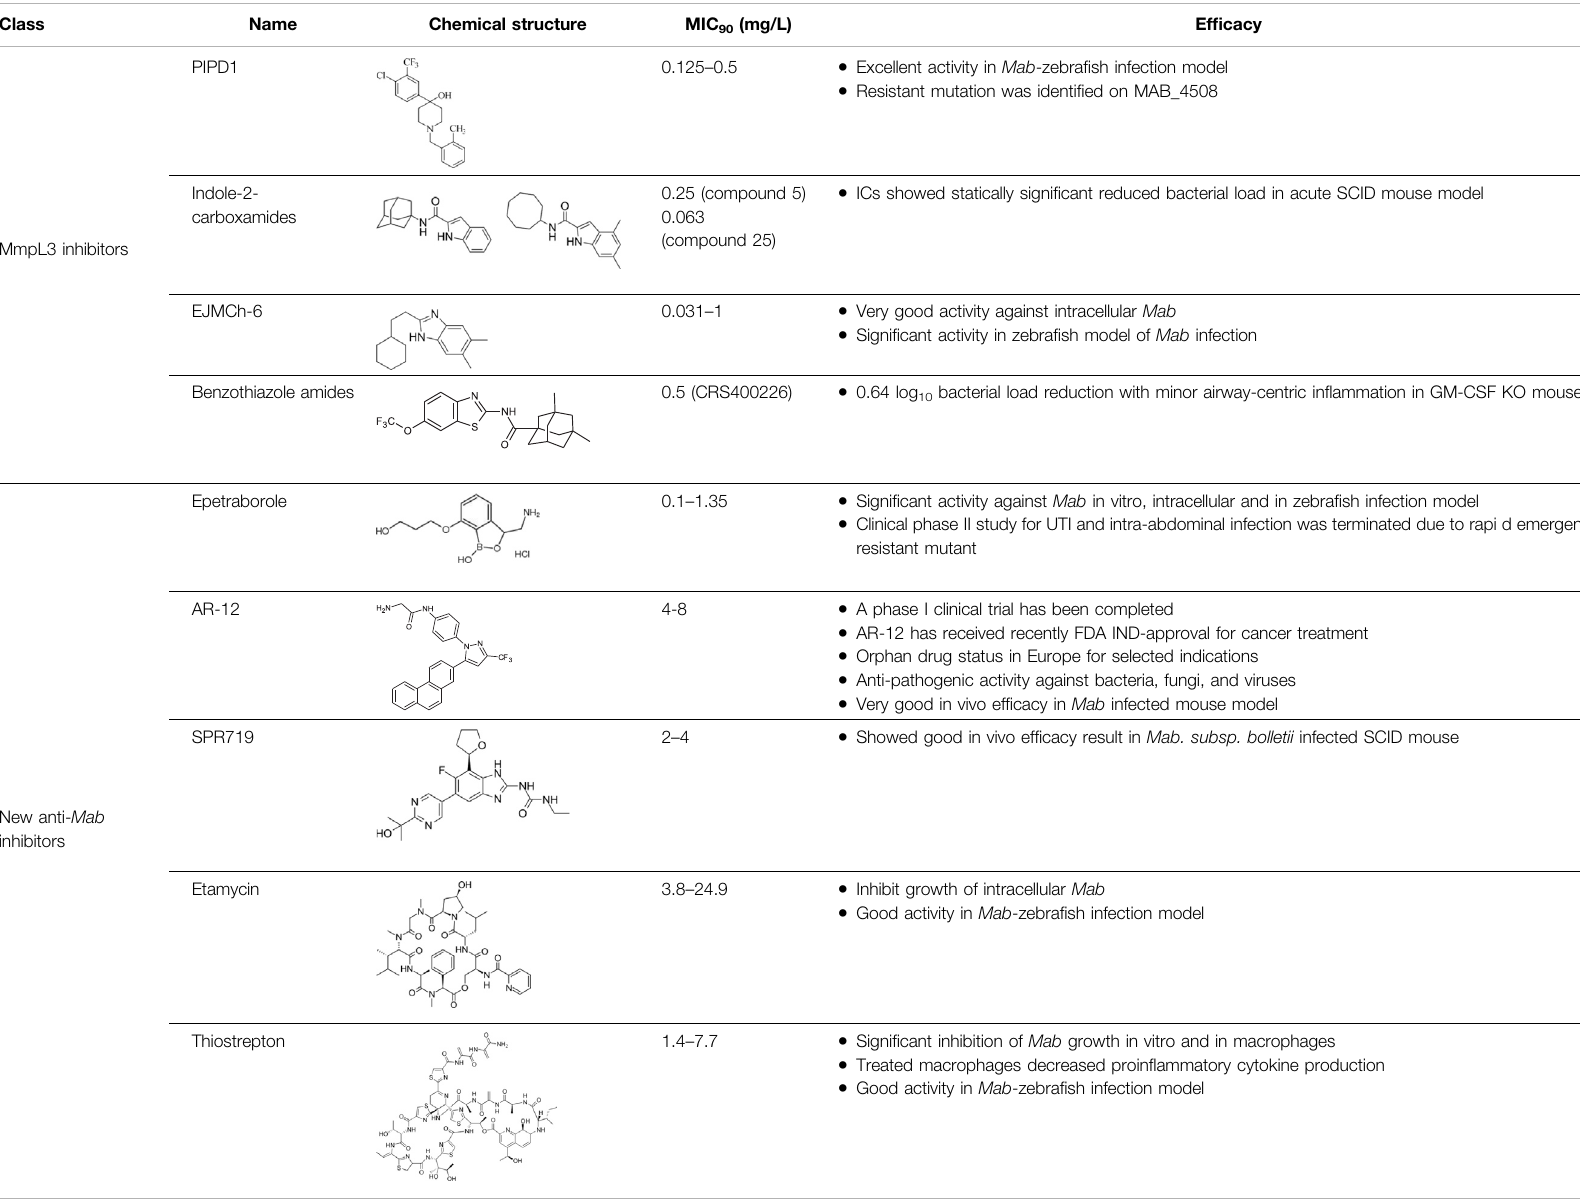
TABLE 2 | ( Continued ) The current state of Mab antibiotics, with compounds currently going through development. * Indicates MIC 50